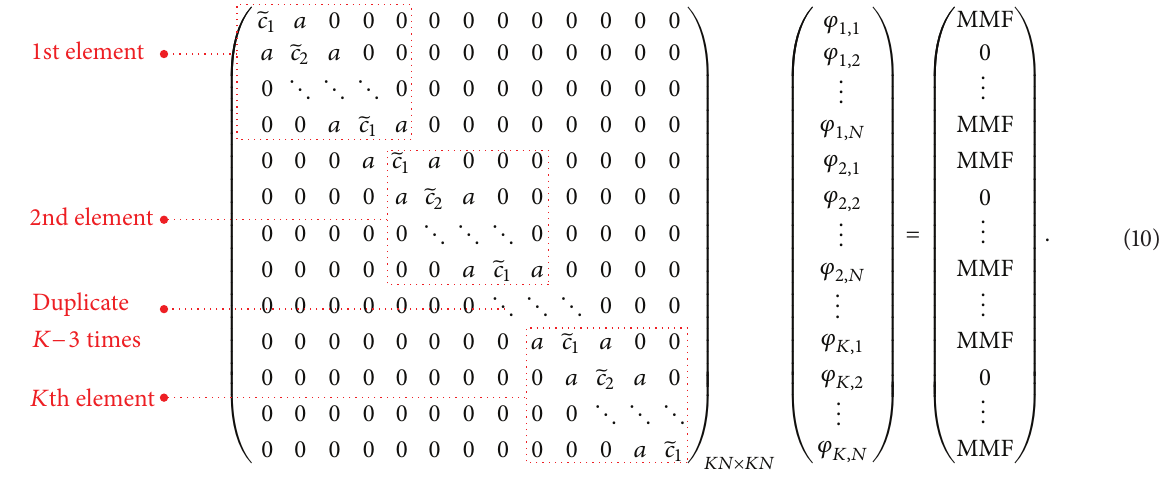
GMM array is calculated,